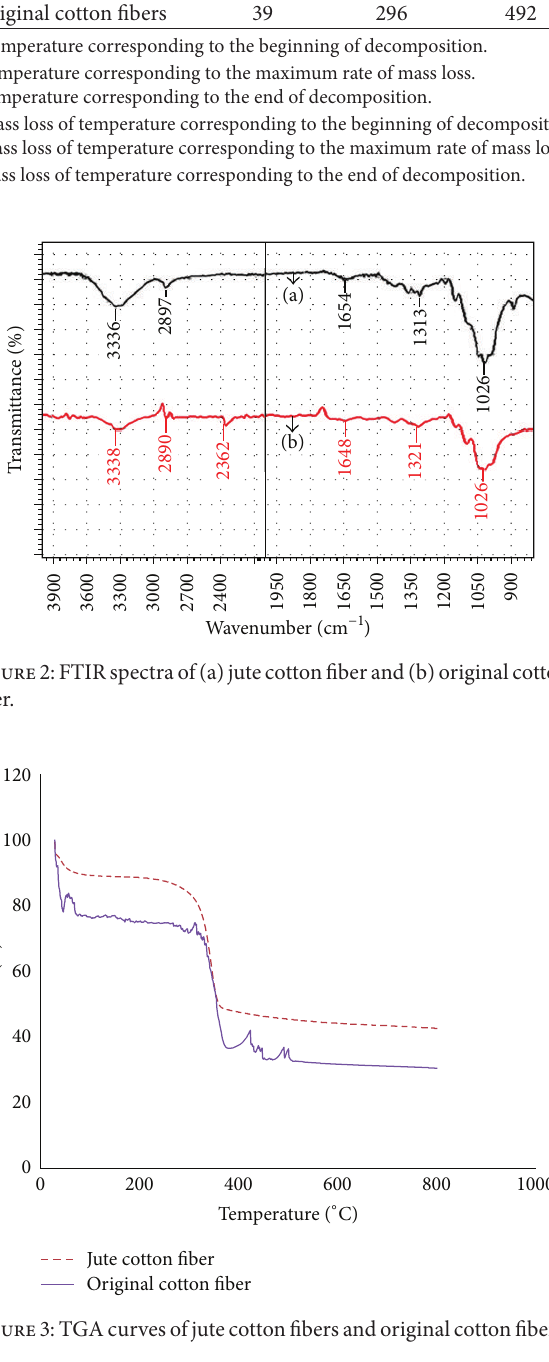
chain of C-C and C=O (200 ∼ 380 ∘ C), and finally (3) aromati- zation ( > 380 ∘ C), the residual chair formation